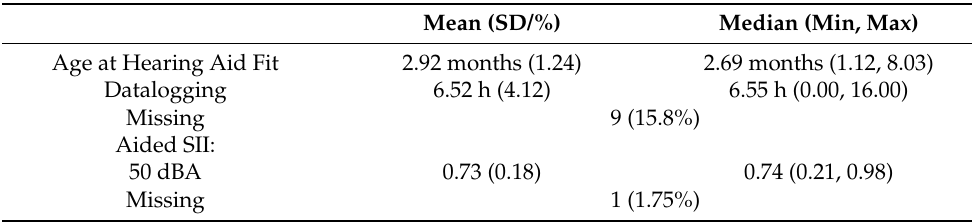
Table 2. Demographics unique to